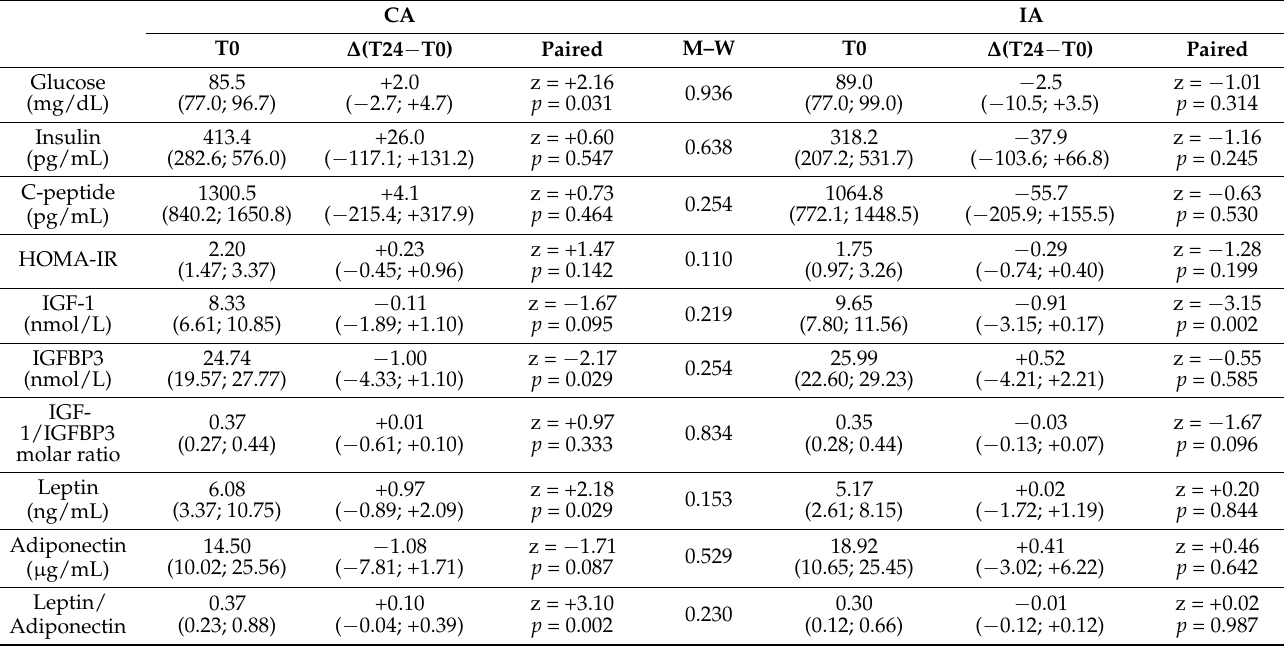
Table 3. Serum metabolic parameters at baseline (T0) and at the end of 24 months of intervention (T24). CA